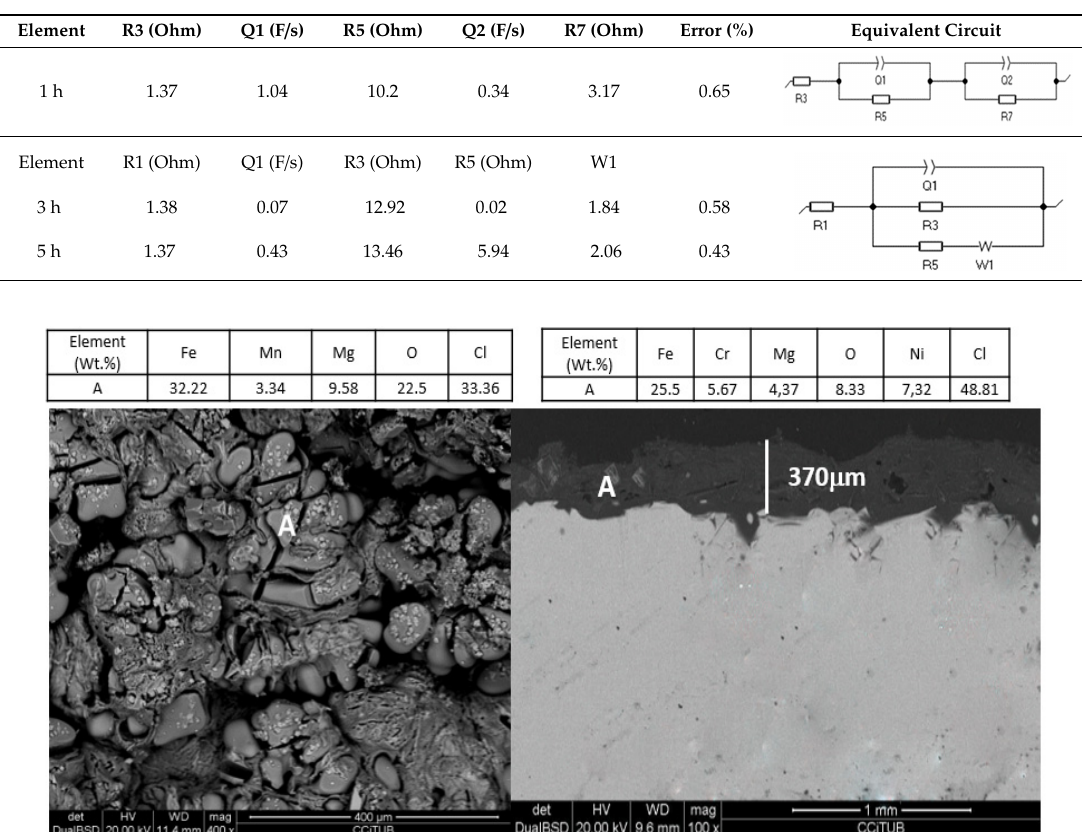
Figure 6. Micrographs showing a top view ( left ) and a cross section ( right ) of OCI immersed in ternary chloride molten salt for 8 h at 720 °C; EDX analysis is shown on top.